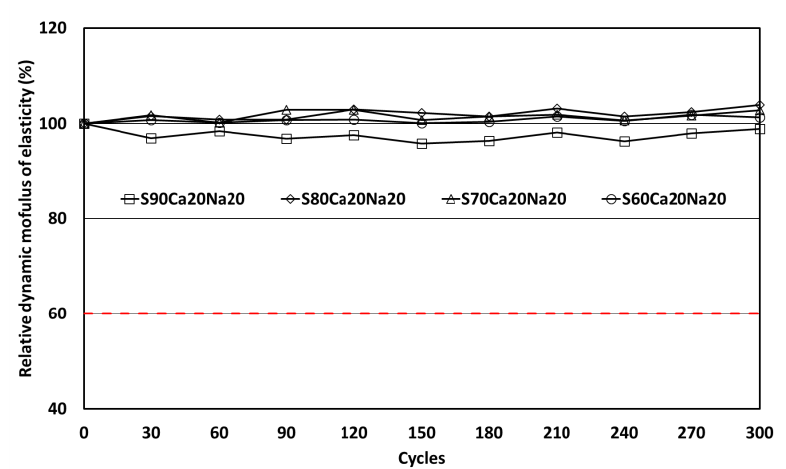
Figure 8. Freeze–thaw resistance experiment results.